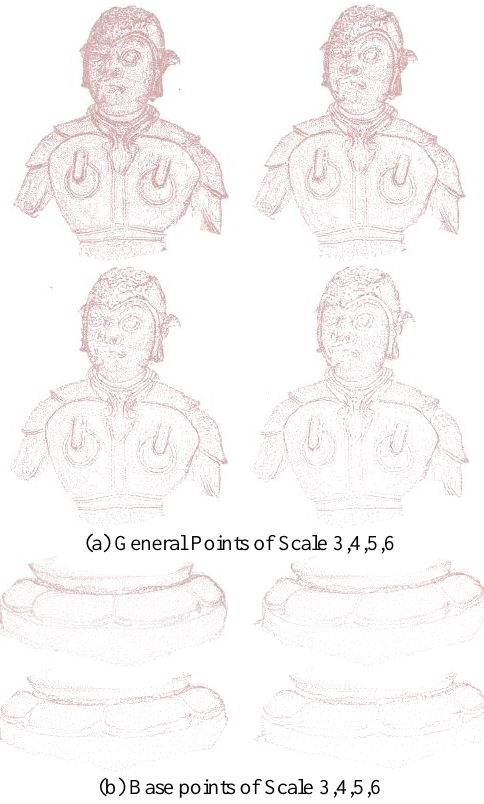
Figure 5. Multi-scale of points extracted